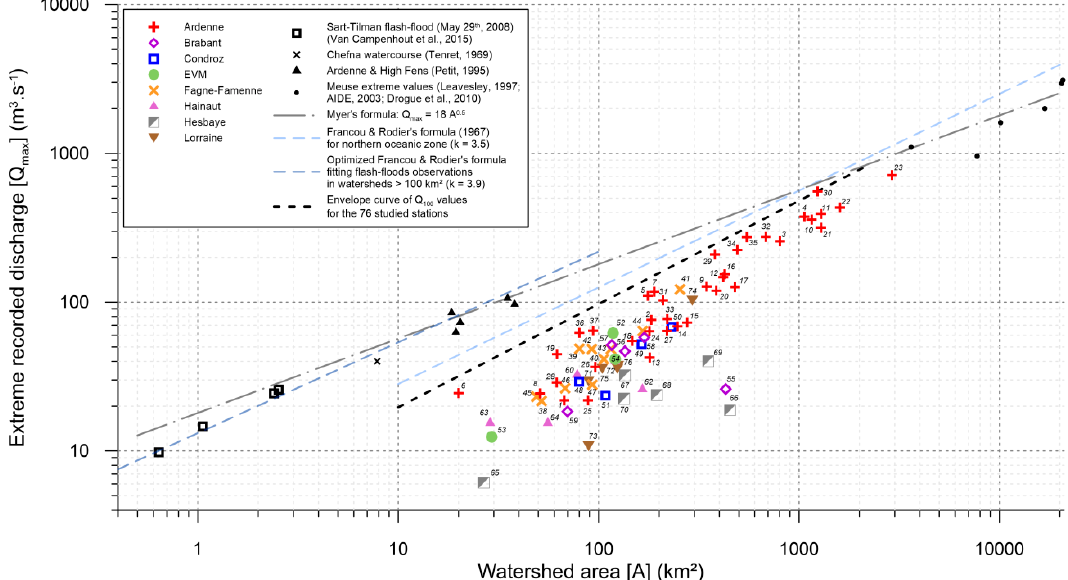
Figure 6. Extreme recorded discharge between 1968 and 2018 in gauged Walloon rivers and the comparison between Myer’s formula (with C = 18) and different flash flood in ungauged watershed (Sart-Tilman flash flood, Chefna watercourse and High Fens watercourses) as well as Meuse 1925-26 large inundation; envelope curve of Q 100 values computed for the 76 studied stations. Francou & Rodier’s formula for northern oceanic zone maximum discharge is also shown as well as the optimized k parameter fitting with extreme floods of Walloon